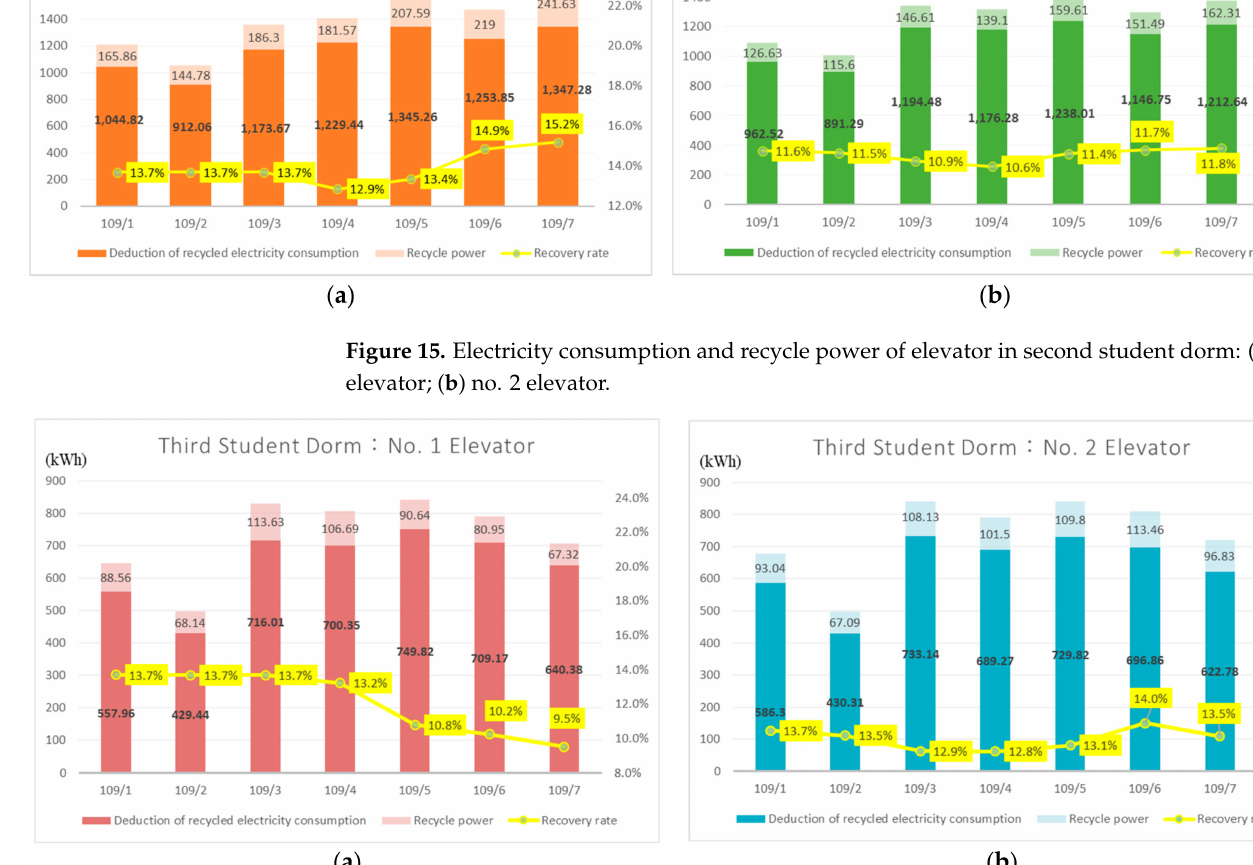
Figure 16. Electricity consumption and recycle power of elevator in third student dorm: ( a ) no. 1 elevator; ( b ) no. 2